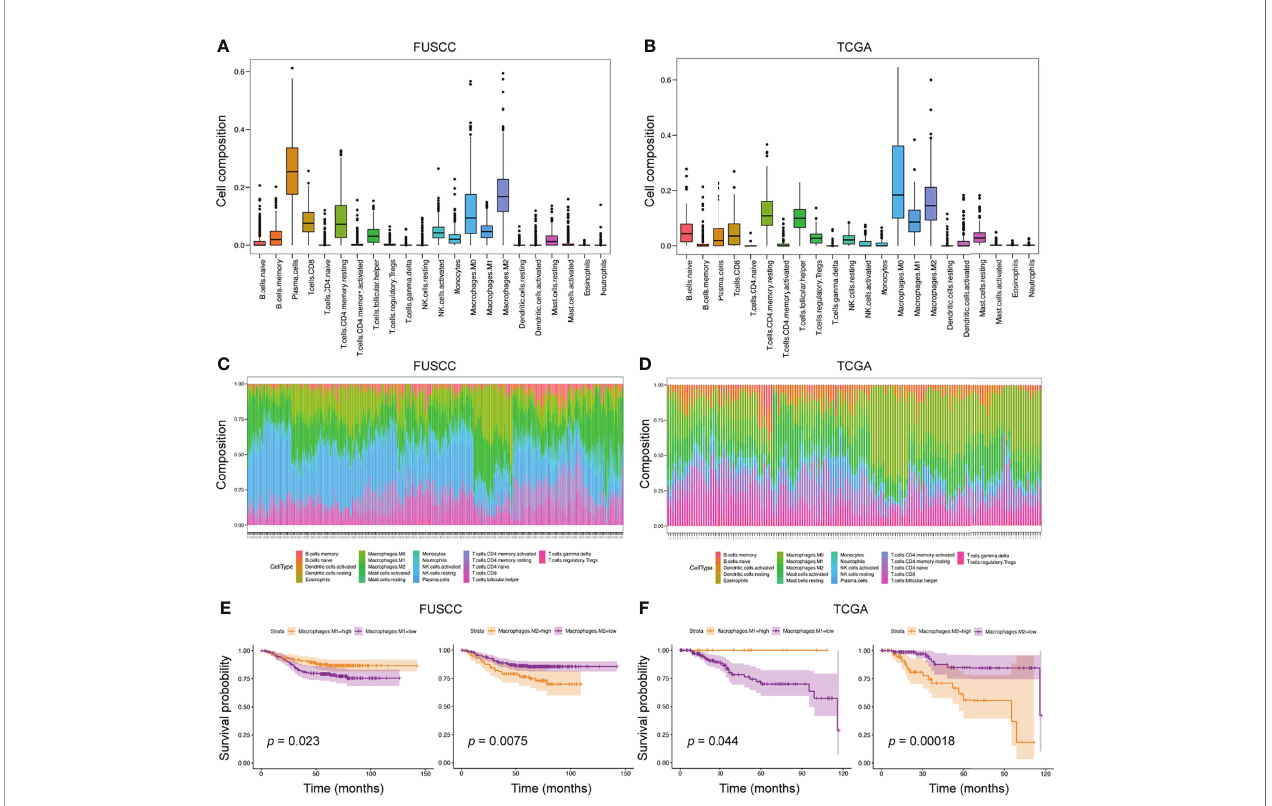
FIGURE 3 | The predominant role of macrophages in TIME from bulk-RNA sequencing analysis. (A, B) We applied the ‘ CIBERSORT ’ package to evaluate the proportion of 22 immune cells in the entire immune microenvironment from 360 FUSCC and 158 TCGA TNBC patients. (C, D) In the bulk-RNA sequencing level, the speci fi c proportion of each patients ’ immune cell types was calculated to check the heterogeneity of TIME. E-F, Survival analysis was used to calculate the effect of high expression of M1 or M2 macrophages on the prognosis of patients. Cohorts, FUSCC (E) and TCGA (F)